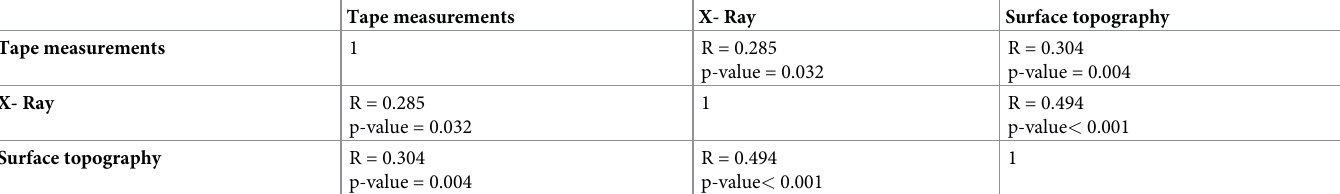
Table 3. Pearson´s correlation between the three methods and standard deviations as shown. Significance level was set at p < 0.05.